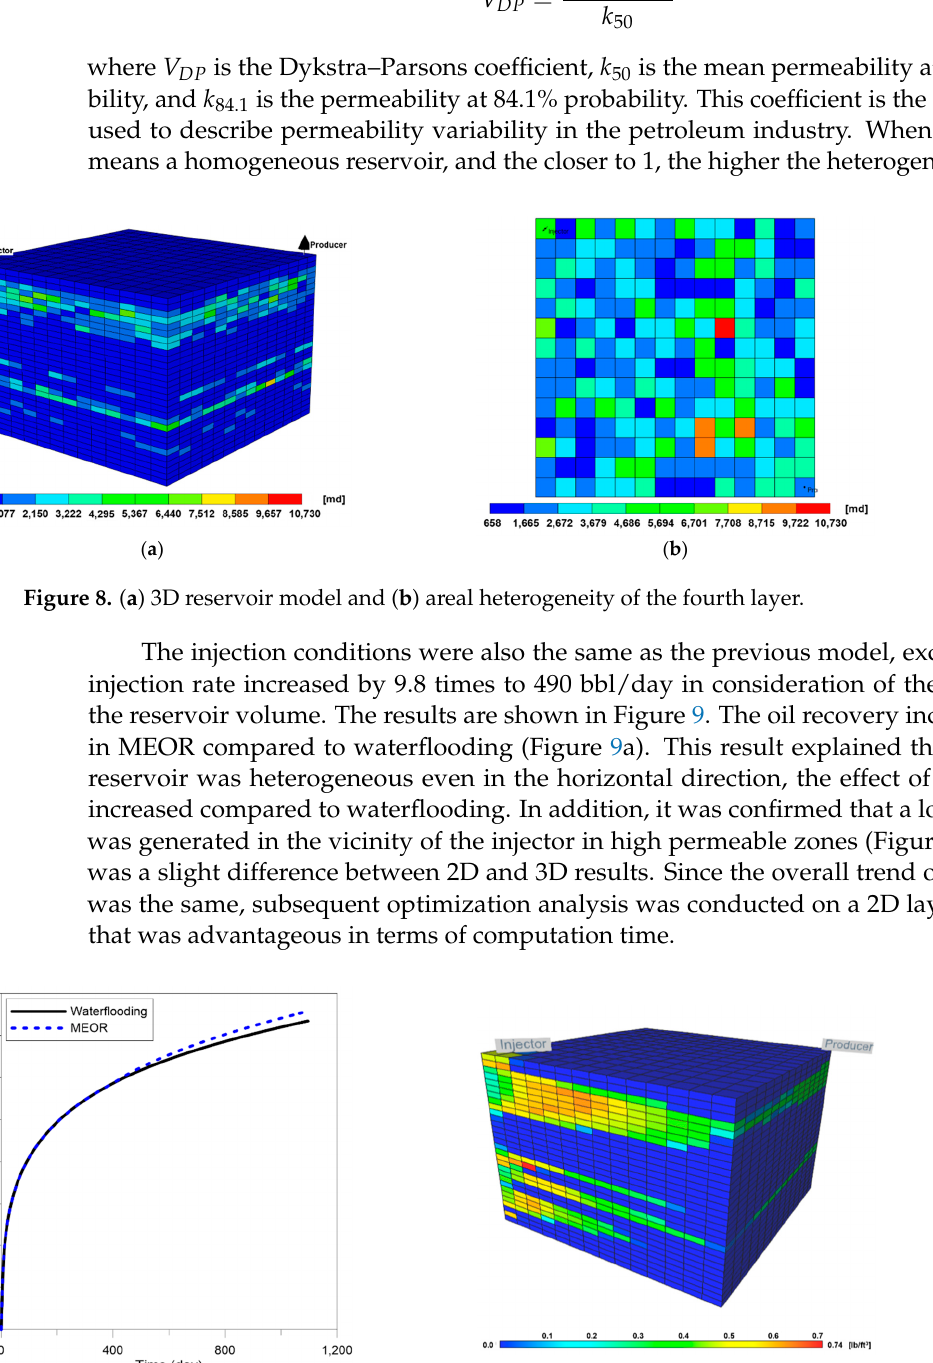
Figure 9. Results for 3D model: ( a ) oil recovery factor, ( b ) dextran generation.